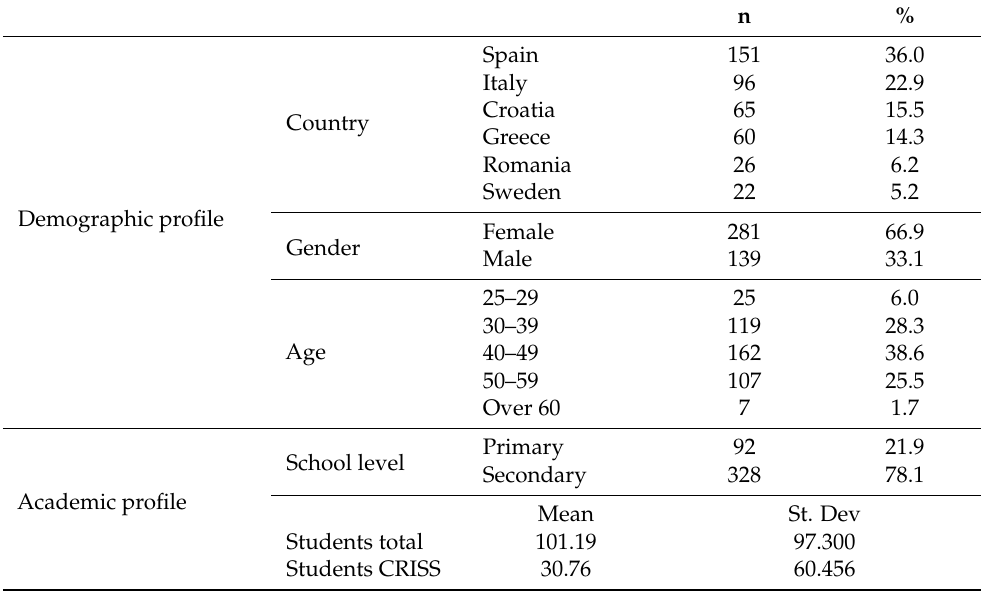
Table 3. Teacher sample